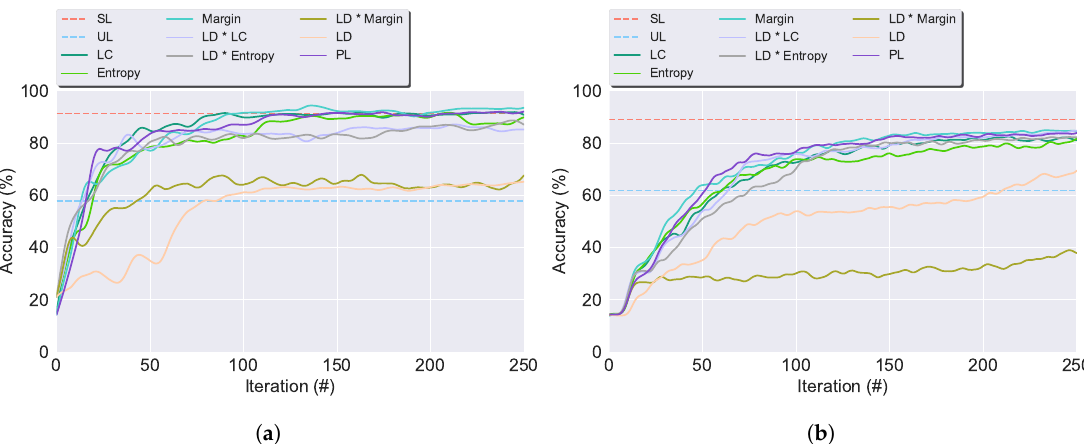
Figure 7. Average increase of the AL classifier’s accuracy for the Query Strategies (QSs) throughout the cycle of iterations. The horizontal lines denote the average accuracy for SL (in red) and UL (in blue). LD denotes the Local Density Sampling and LC the Least Confident Sampling. ( a ) UCI dataset. ( b ) CADL